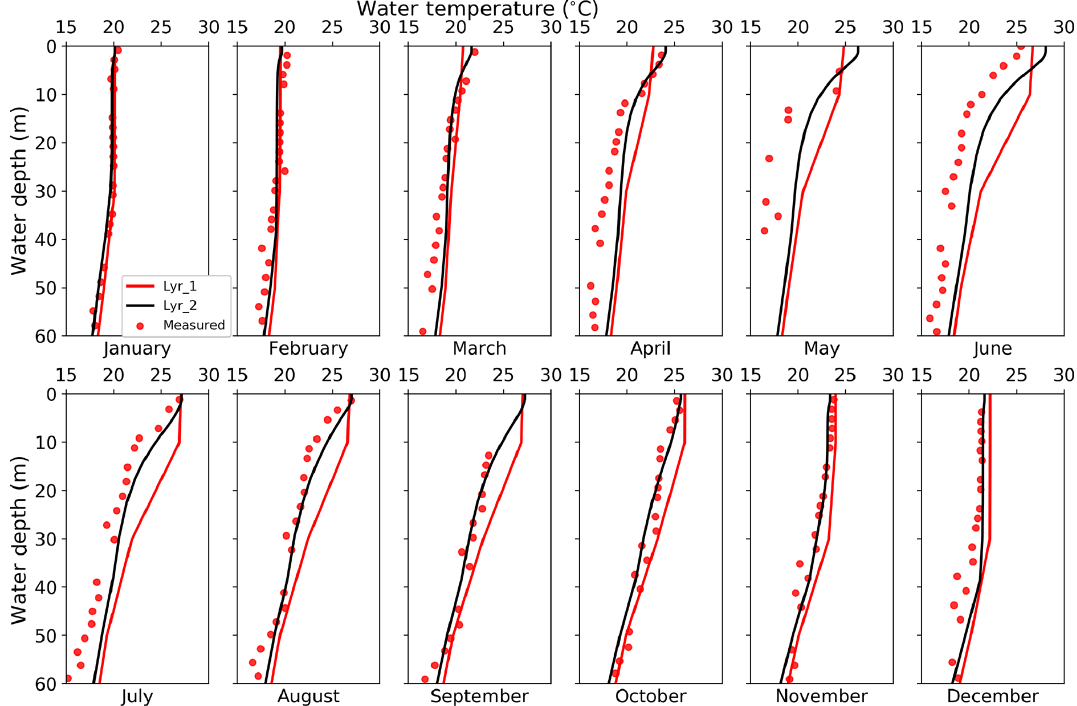
Figure 7. Monthly vertical temperature profile for the first 60m water by observation (red dots), Lyr_1 (red line), and Lyr_2 (black line) in the year